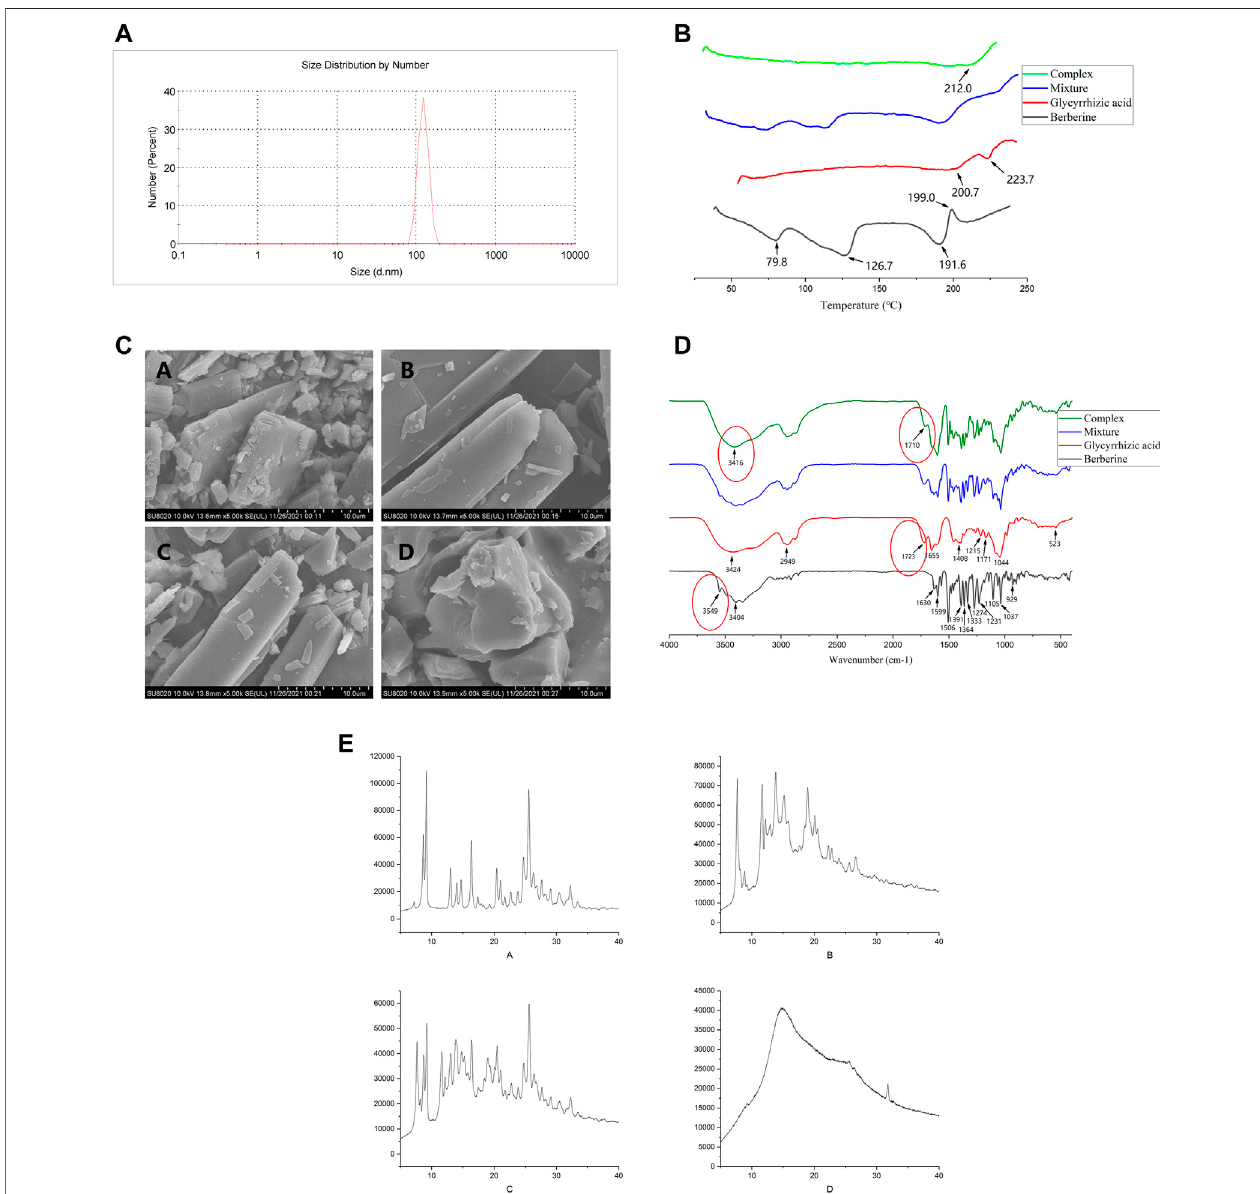
FIGURE 3 | Characterization of the BBR-GL complex. (A) . Size distribution of BBR-GL complex. (B) . SEM of (A) BBR, (B) GL, (C) mixture, and (D) BBR-GL complex. (C) . DSC of (A) BBR, (B) GL, (C) mixture, and (D) BBR-GL complex. (D) . FT-IR of (A) BBR, (B) GL, (C) mixture, and (D) BBR-GL complex. (E) . PXRD of (A)